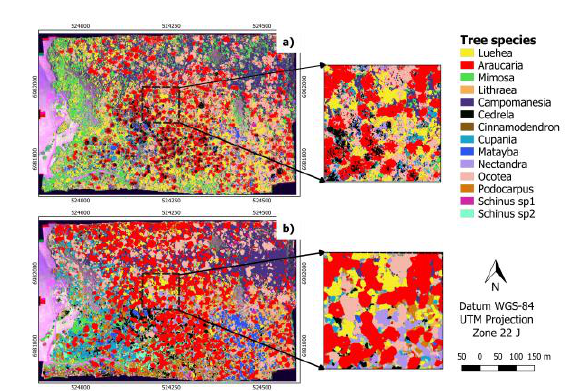
Figure 6. Classified images. (a) RF classifier; (b) CNN